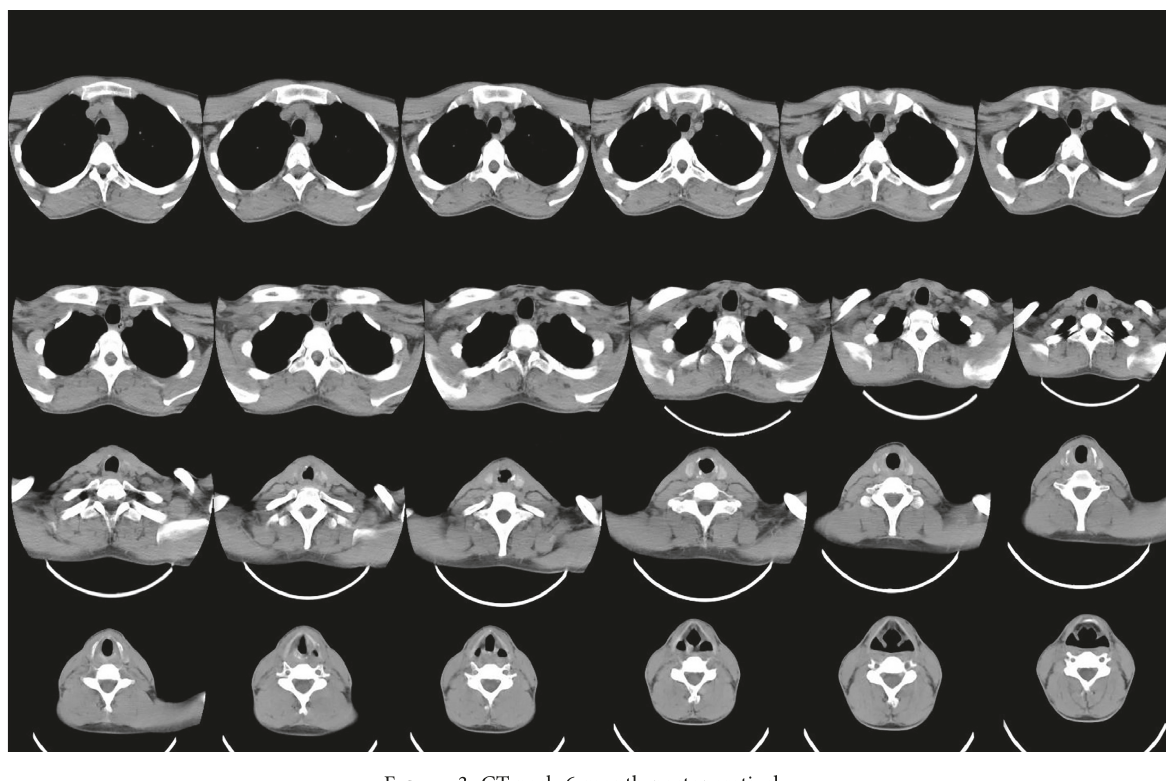
Figure 3: CT neck 6 month postoperatively.